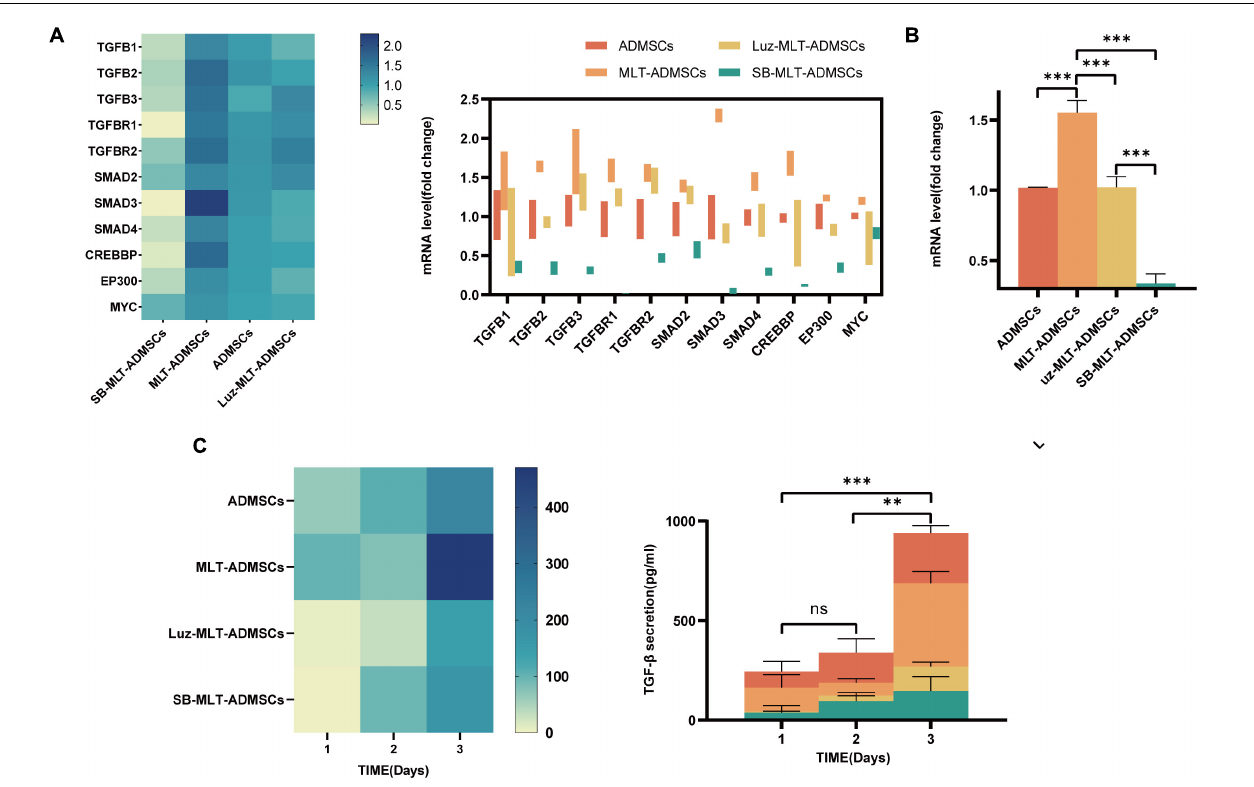
FIGURE 9 | MLT activates the TGF- β pathway in ADMSCs. (A) TGFB expression level. (B) TGF- β pathway expression level. (C) ELISA was used to detect the amount of TGF- β secretion. Values in this figure are the mean ± SE; n = 3 per group; ns > 0.05, ∗ p < 0.05, ∗∗ p < 0.01, ∗∗∗ p < 0.001 determined by a repeated-measures